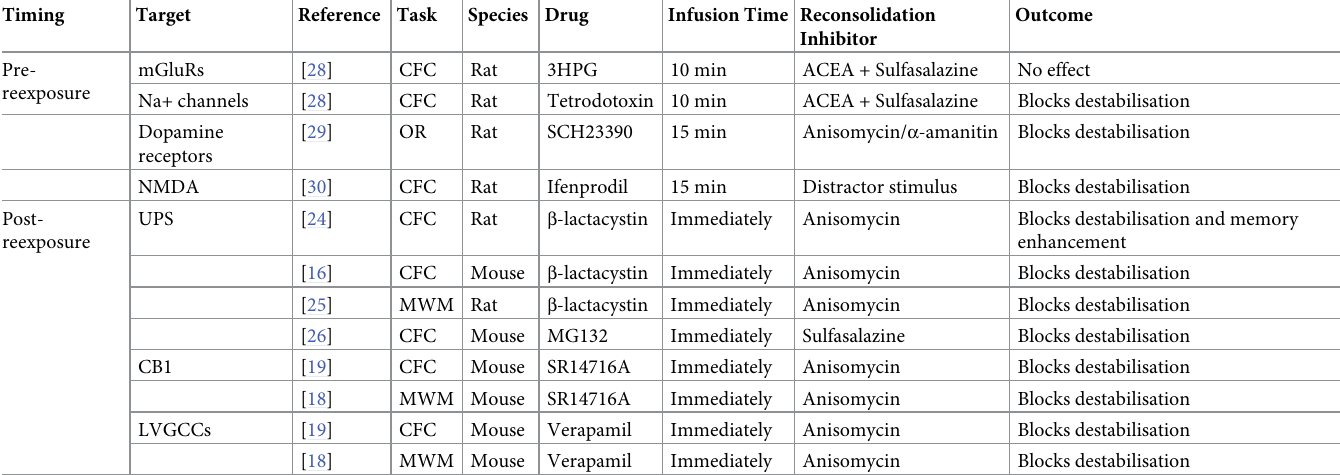
Table 2. Involvement of different molecular mechanisms in memory destabilisation before and after its reactivation in the